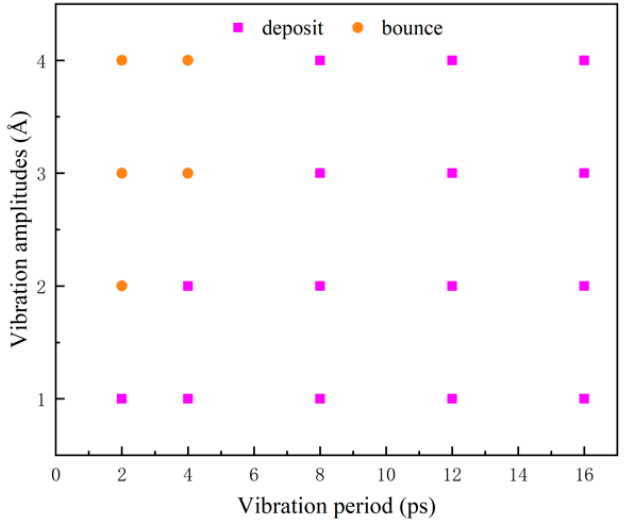
Figure 18. The bounce domain as water nanodroplets impinge on vibration surfaces.